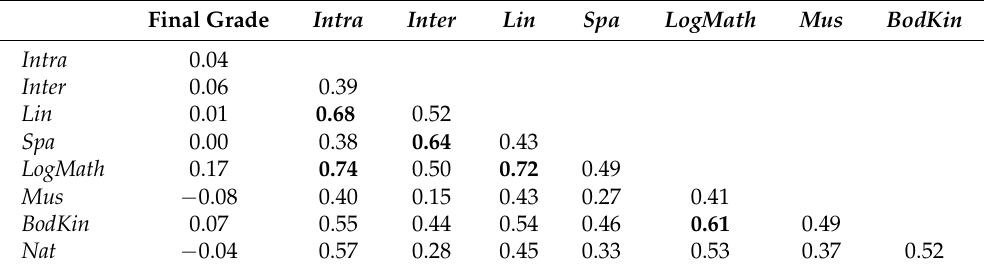
Table 7. Correlations table for MI dimensions.